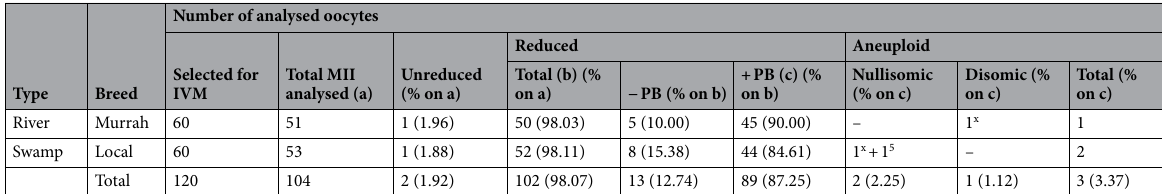
Table 1. River and swamp buffalo secondary oocytes matured in vitro and analysed by sequential M-FISH with 6 chromosome specific painting probes for aneuploidy detection. IVM in vitro maturation, PB polar body, PSSC premature separation of sister chromatids. (a) Number of matured oocytes; (b) Number of oocytes with reduced chromosome number; (c) Number of oocytes with reduced chromosome number and analysable